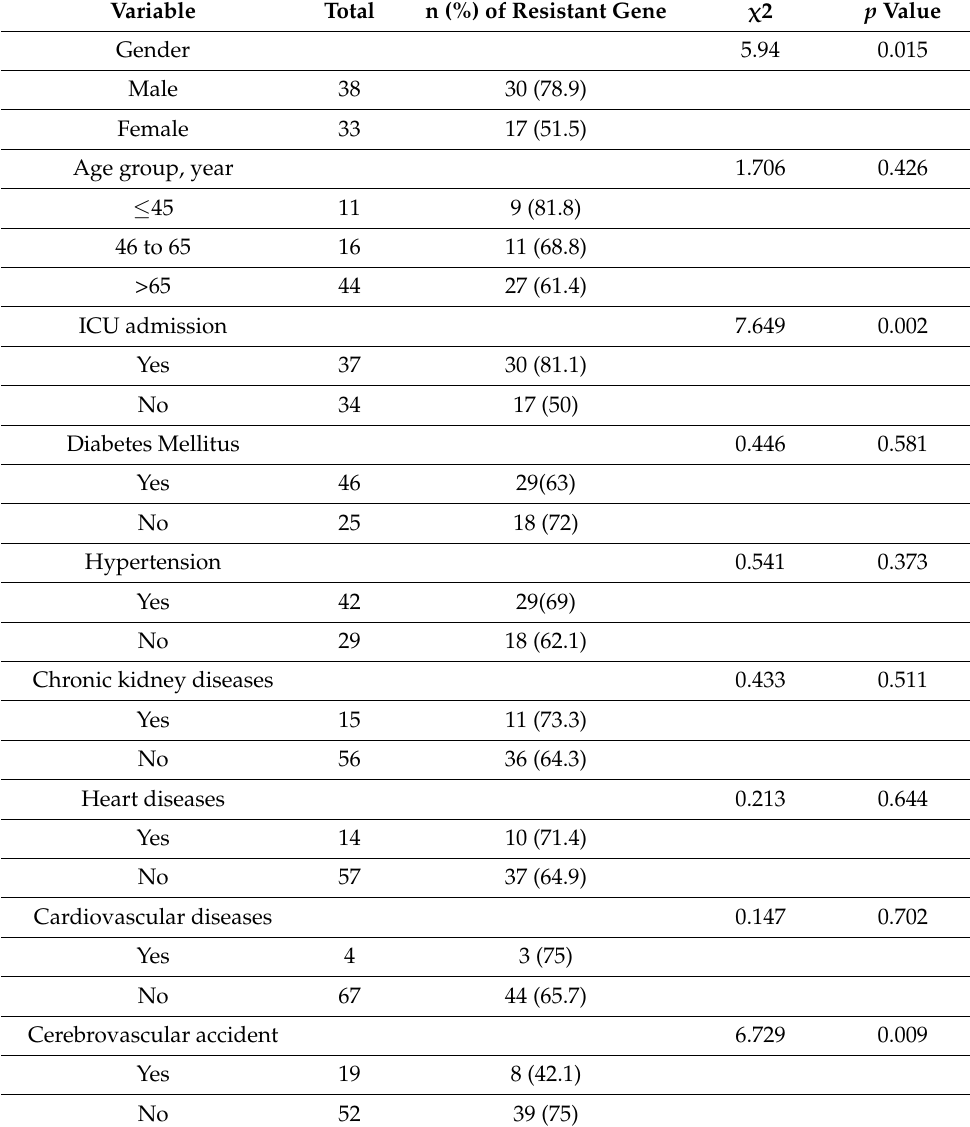
Table 4. Factors associated with the presence of resistance-gene-carrying Klebsiella pneumoniae